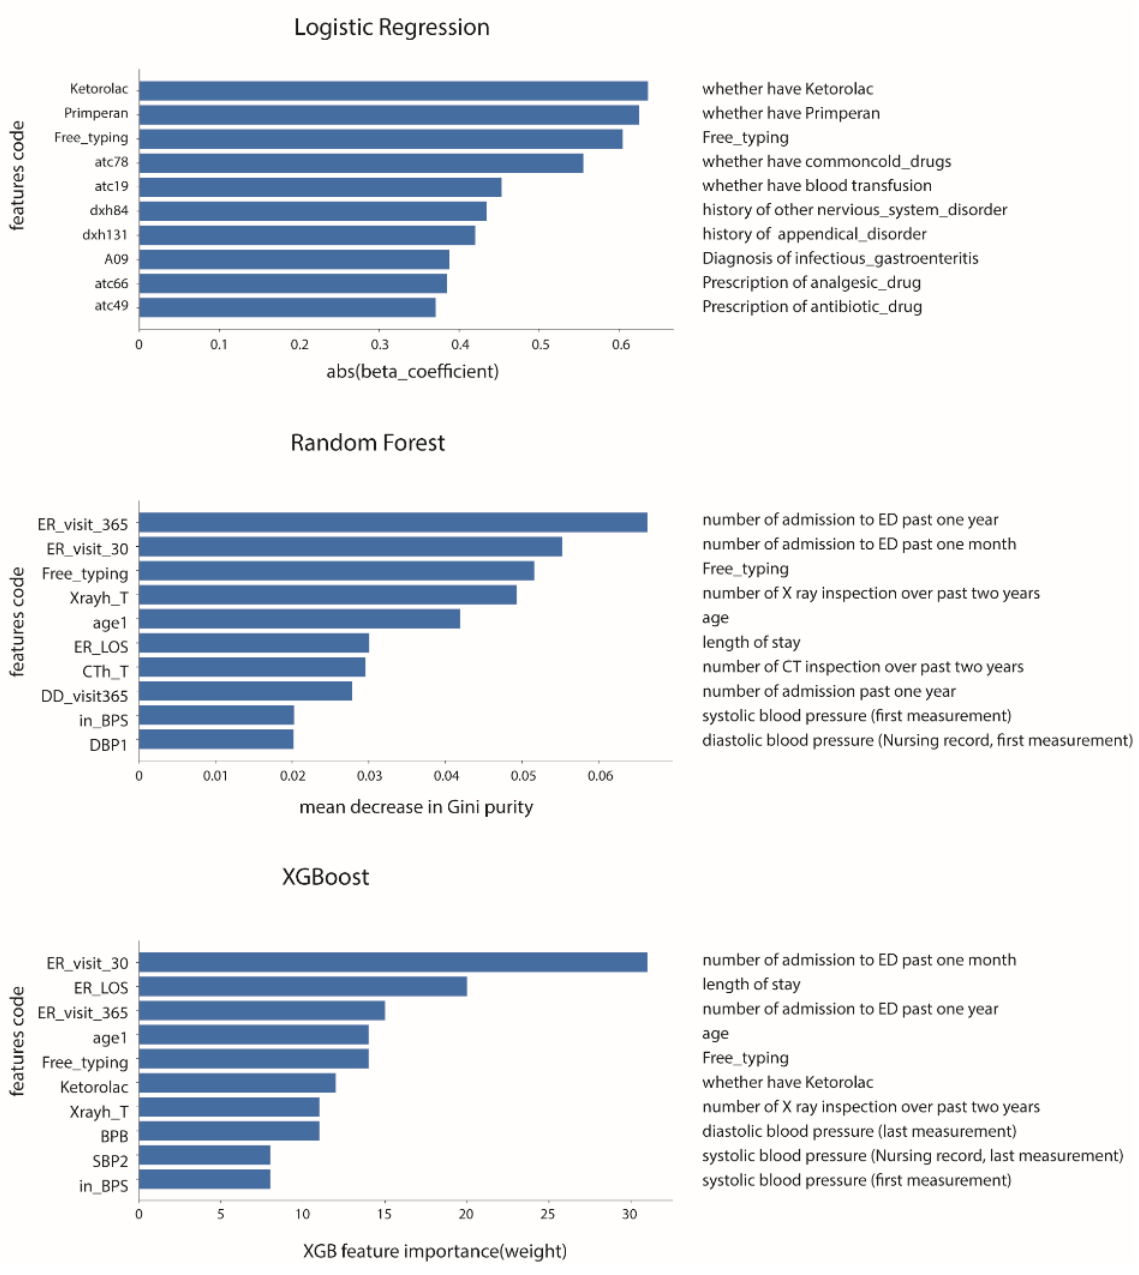
Figure 3. Top 10 important features extracted by each model.